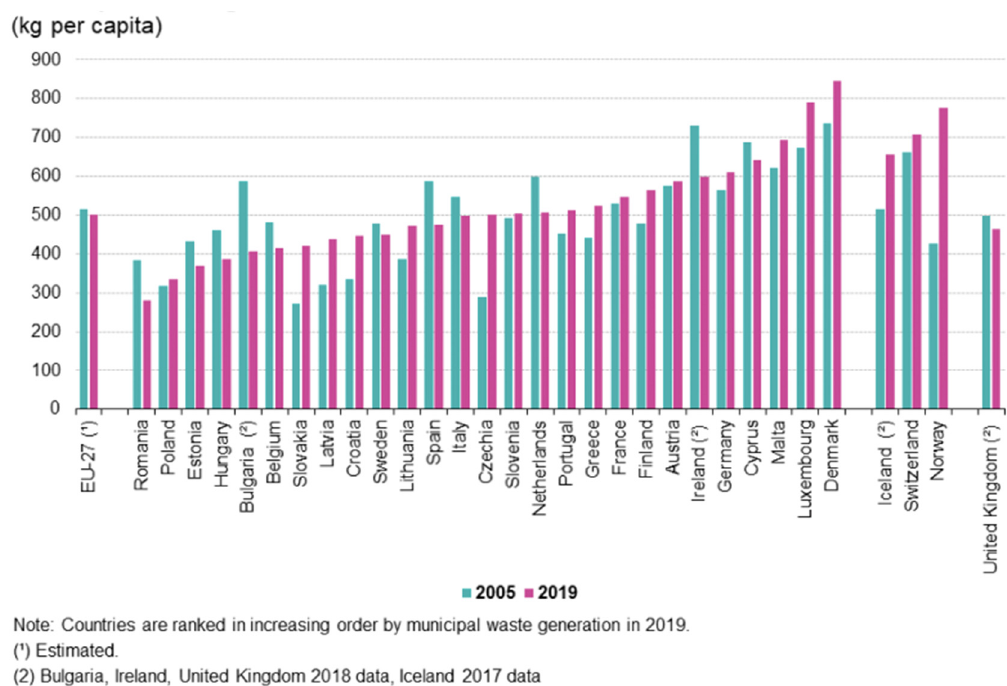
Figure 1. Municipal waste generated, 2005 and 2019. Source: Eurostat [7].